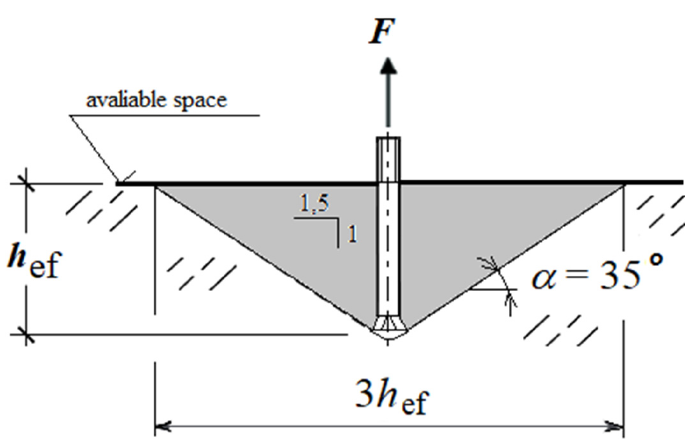
Figure 2. Model of the concrete cone failure under the action of the undercut anchor, according to the CCD method: h ef —effective anchoring depth; α —the angle of failure cone (pseudo-cone of fail- ure).